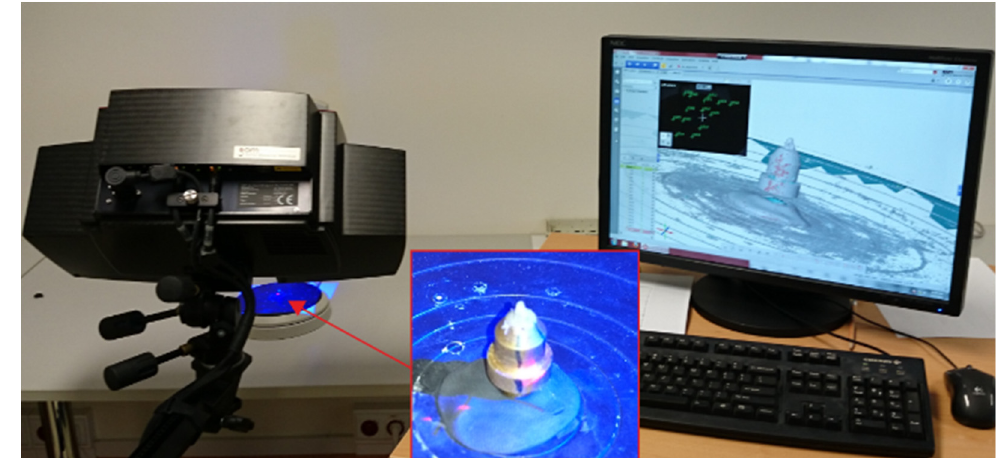
Figure 2. A test stand for scanning abrasive grains.